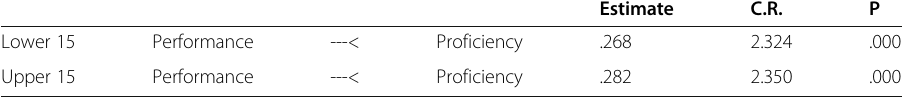
Table 9 Standardized Regression Weights: (data - Default model) for work experience of participants Estimate C.R. P Lower 15 Performance ---< Proficiency .268 2.324 .000 Upper 15 Performance ---< Proficiency .282 2.350